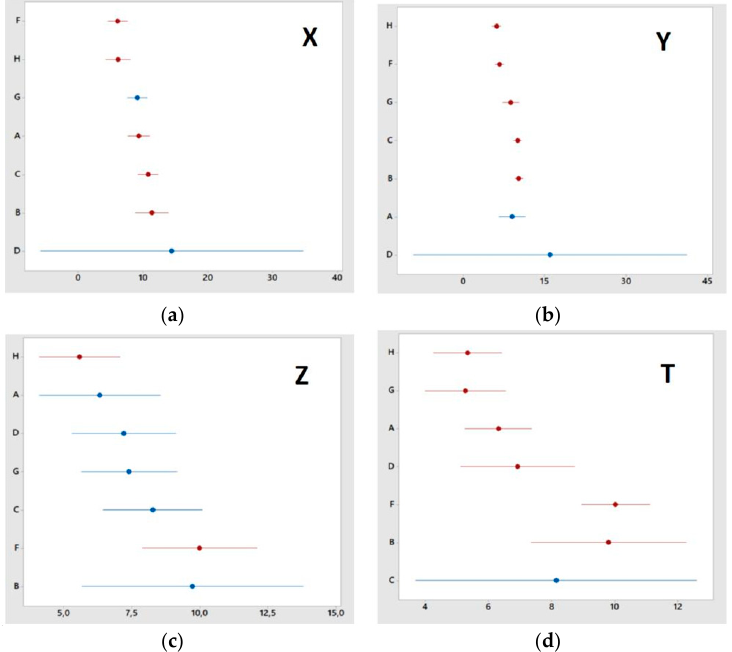
Figure 25. Ra (µm) represents the comparison for each direction across players. Roughness on the ( a ) X, ( b ) Y, ( c ) Z, ( d ) T